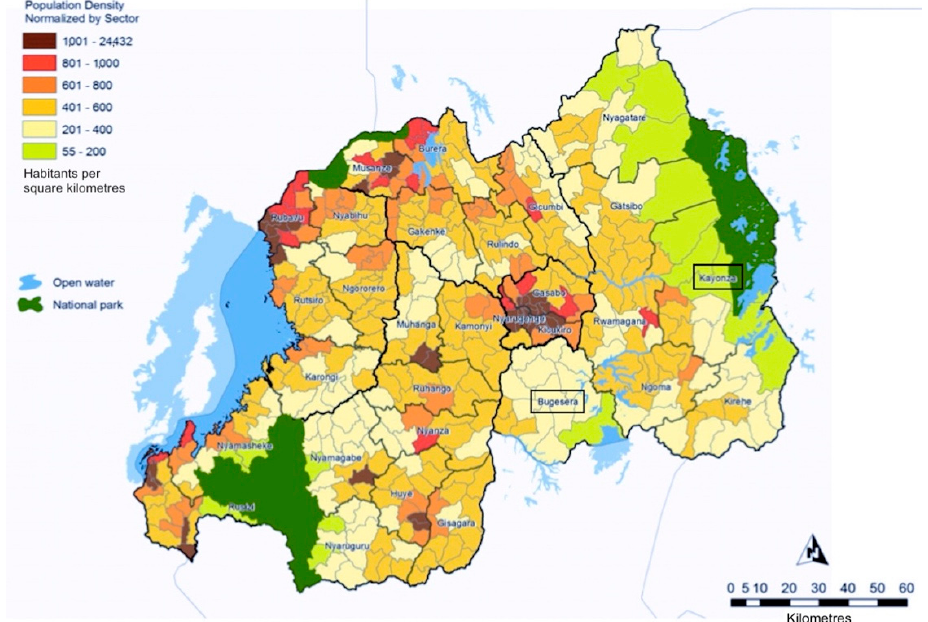
Figure 2. Population density normalized to sector (adapted from [59]). Table 1. Bboxx customers, population and population density by sector (adapted from